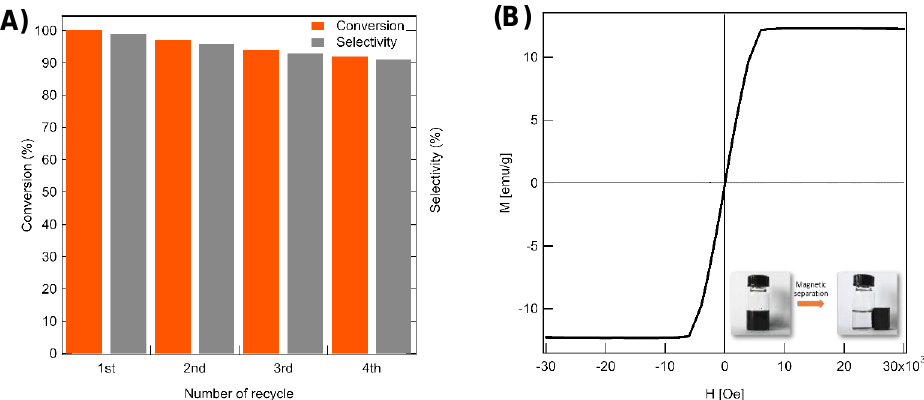
Figure 1. ( A ) The recycling performance of the reductive coupling of nitrobenzene with benzyl alcohol under standard reaction conditions and ( B ) magnetic hysteresis loop (300 K) of the catalyst CoO x @NC-800; inset is the illustration of separation by external magnet.